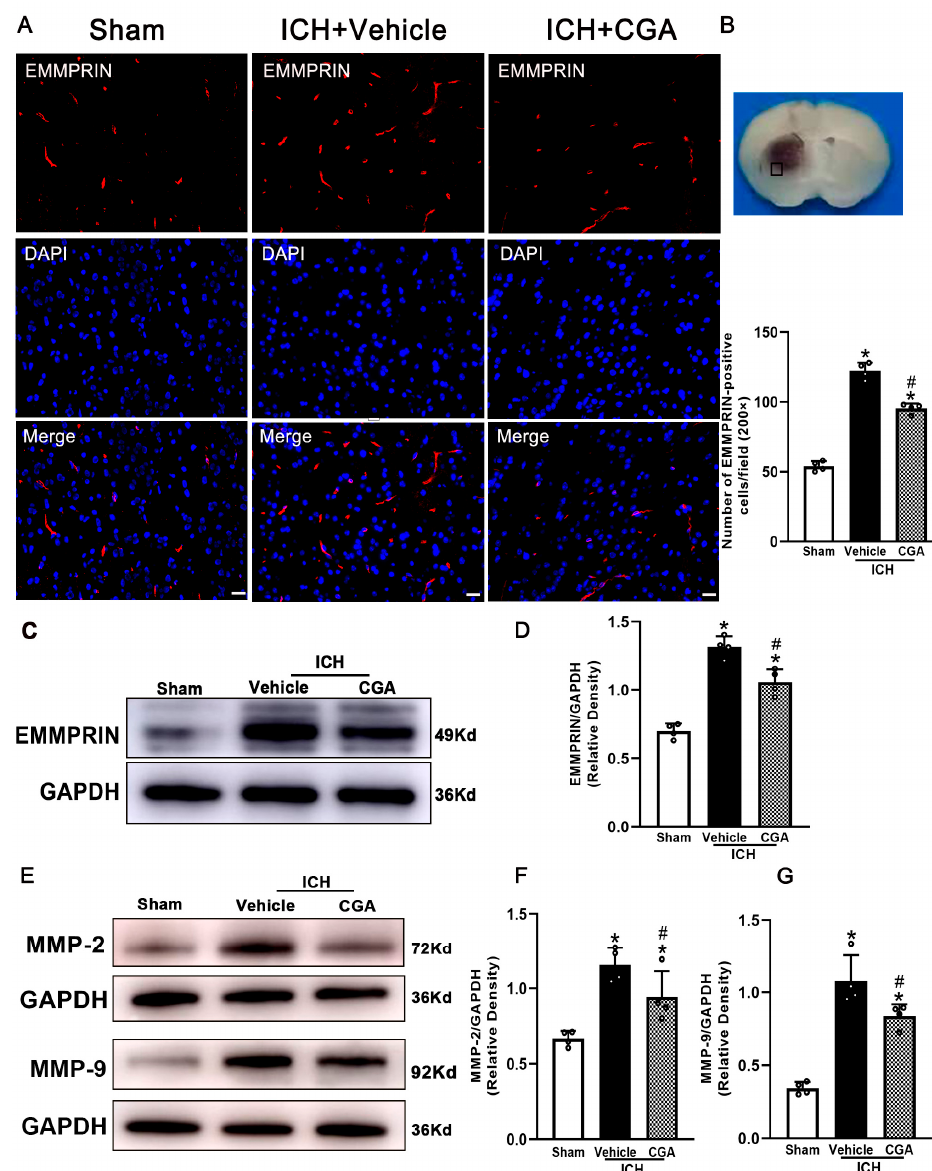
Figure 3. CGA attenuates EMMPRIN and MMP-2/9 expression in mice subjected to ICH. ( A ) Immunostaining of EMMPRIN expression in the perihematomal region at 3 days after ICH. ( B ) The bar graph shows that CGA treatment reduces the number of EMMPRIN cells. ( C ) Western blotting was performed to detect protein levels of EMMPRIN, which showed that CGA reduced the expression of EMMPRIN at 3 days after ICH. ( D ) The bar graph indicates the density of EMMPRIN versus GAPDH in different groups. ( E ) Western blotting was performed to detect protein levels of MMP-2 and MMP-9. CGA reduces the expression of MMP-2 and MMP-9 at 3 days after ICH. ( F , G ) The bar graph indicates the density of MMP-2 and MMP-9 versus GAPDH in different groups. * p < 0.01 vs. sham; # p < 0.05 vs. ICH + vehicle group. Data are presented as mean ± SD; n = 4 for each group; scale bar = 20 µ